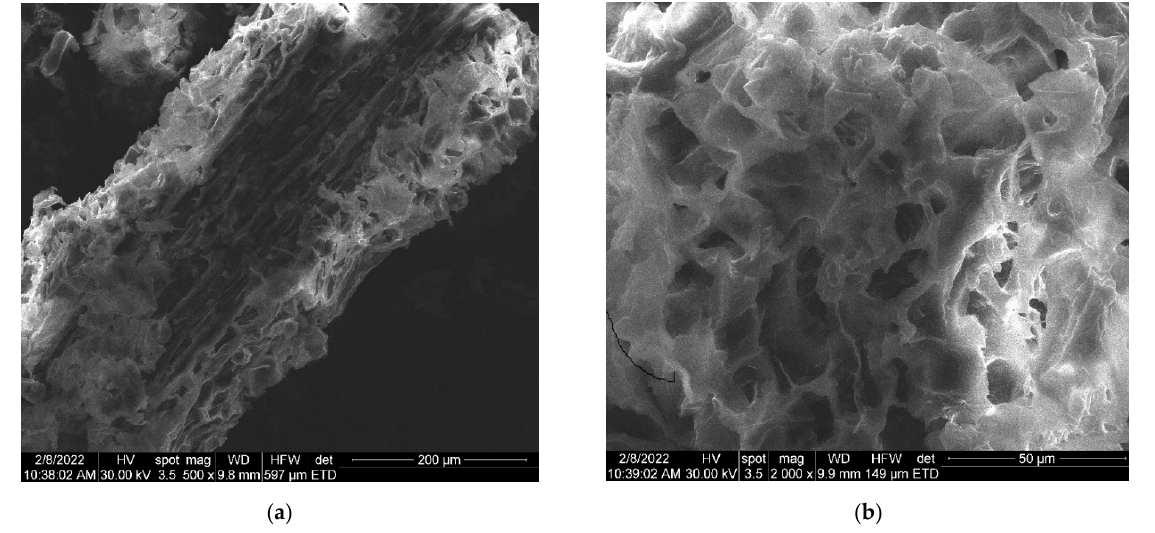
Figure 5. Two-dimensional image of the AuNPs obtained by the SEM technique.